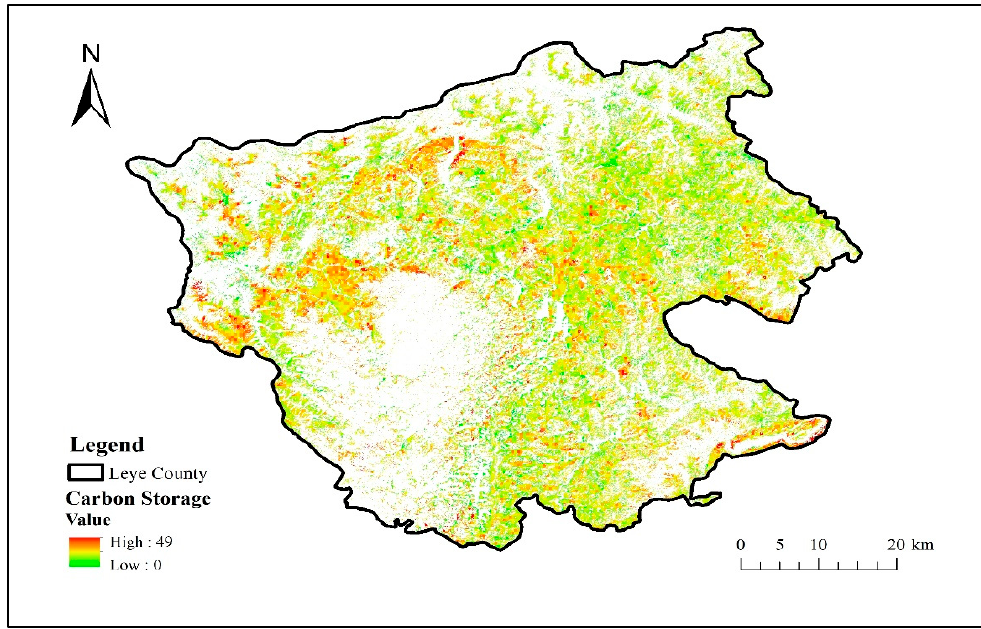
Figure 8. Carbon storage (Mg C/ha) distribution map of Illicium verum in Leye County.